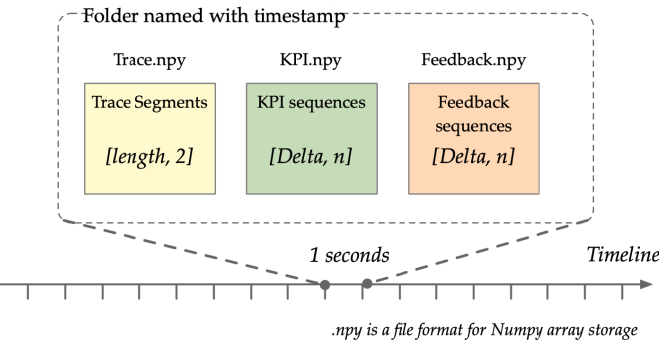
Figure 2. An example of the structure of multimodal datasets.